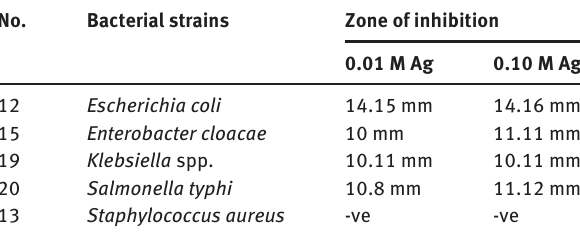
Figure 4 UV-Vis spectra of silver-polyvinyl alcohol